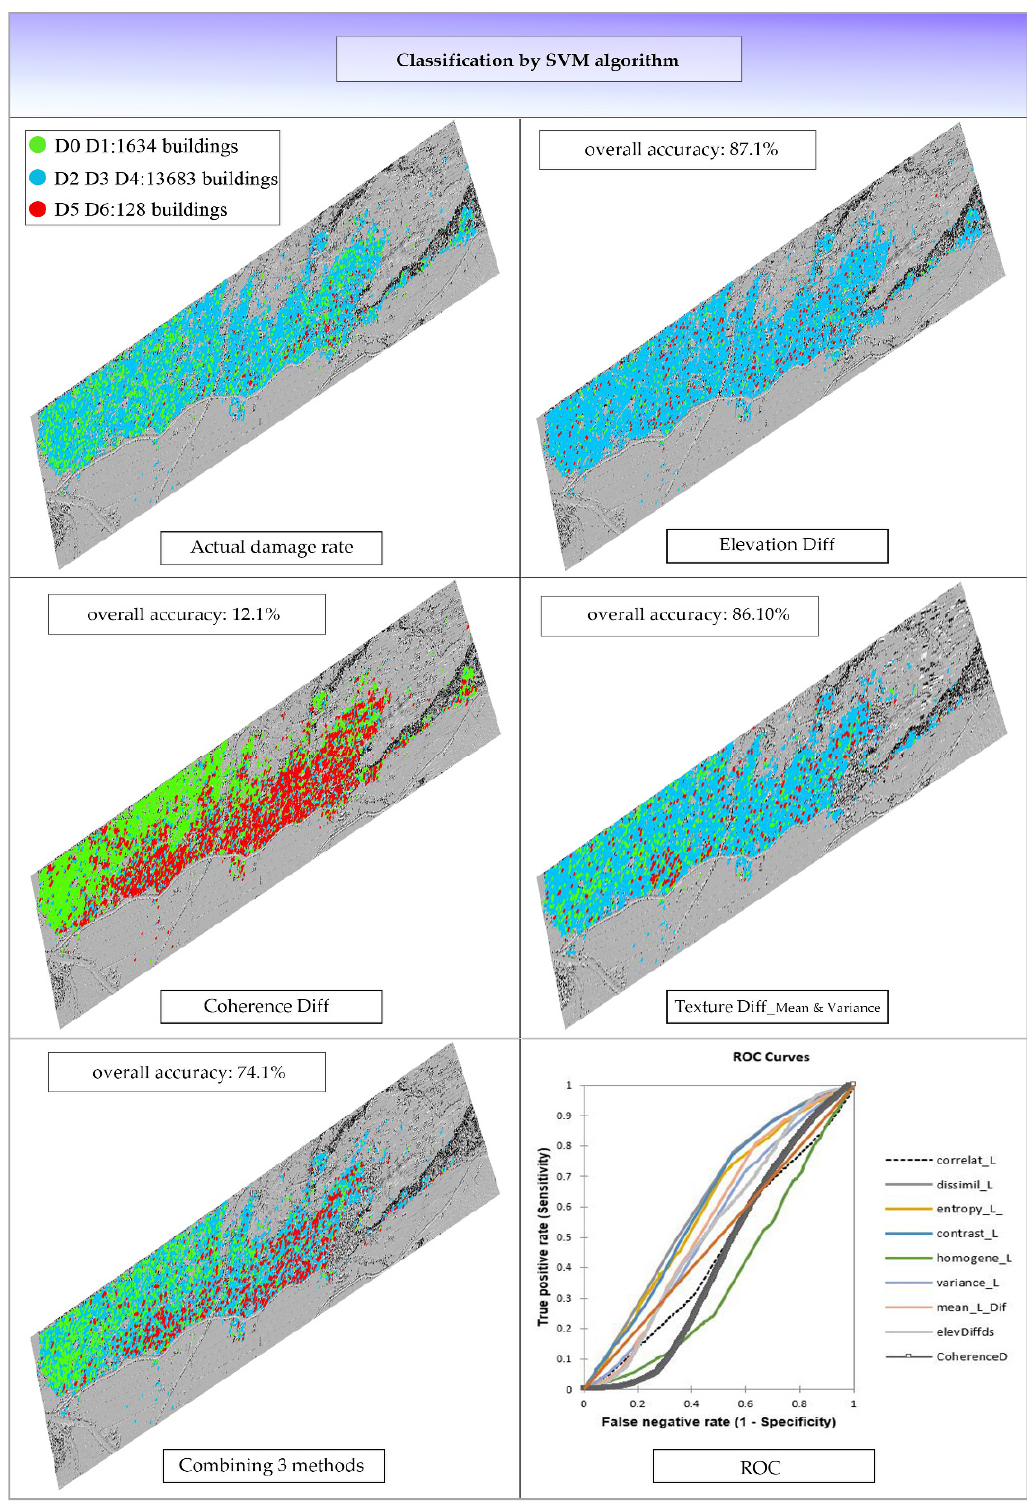
Figure 10. The estimation results of the building conditions by SVM algorithm with considering 4 methods. The green spots represent the intact buildings, blue spots show low to moderate damage and the red spots represent the collapsed buildings. In addition, the Receiver’s Operating Characteristic (ROC) [36] curve (3DR) is shown.